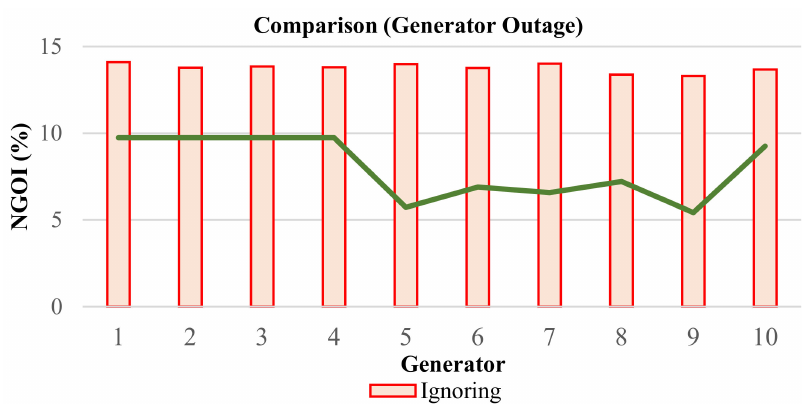
Figure 11. The NGO indexes of generators for different